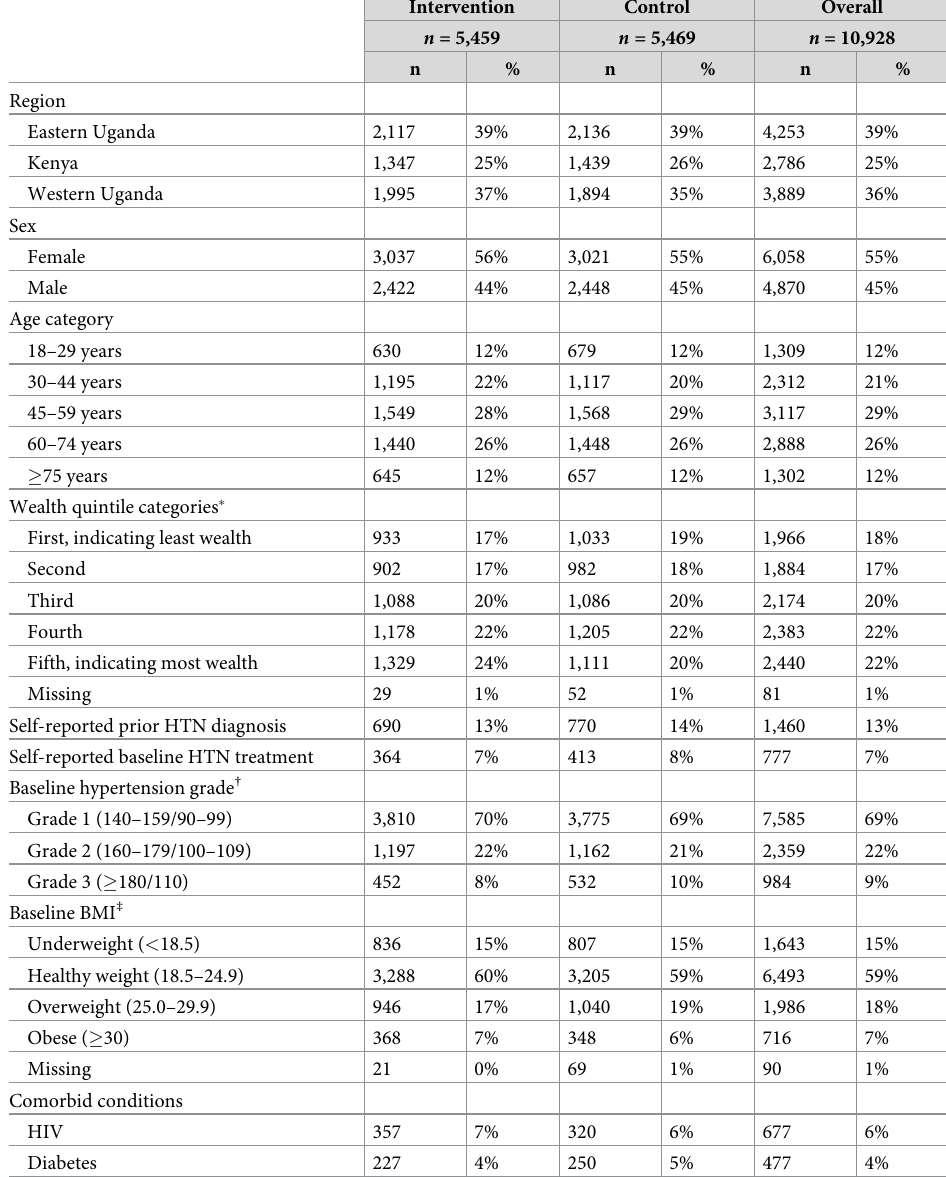
Table 1. Baseline characteristics of nonpregnant adults with baseline uncontrolled